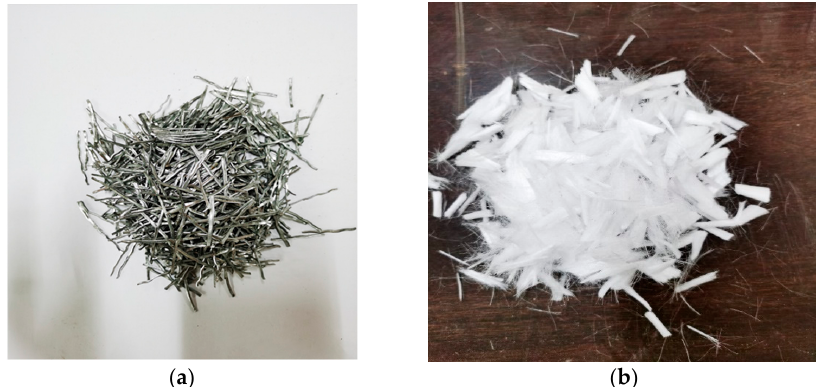
Figure 1. Digital images of the fiber: ( a ) steel fiber; ( b ) polypropylene fiber.